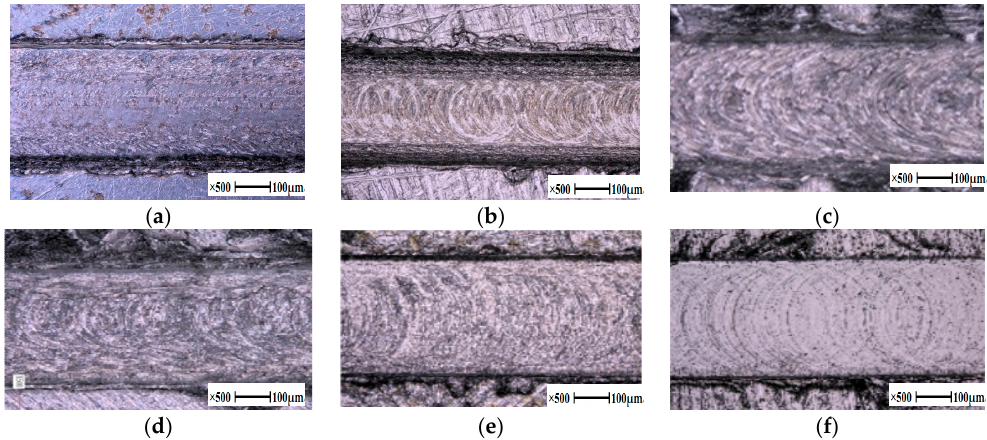
Figure 8. High view microscope picture of micro grooves versus material. ( a ) 45, ( b ) 304, ( c ) 5083-O, ( d ) 6082-T6, ( e ) SKH-9, ( f ) Ti6Al4V.